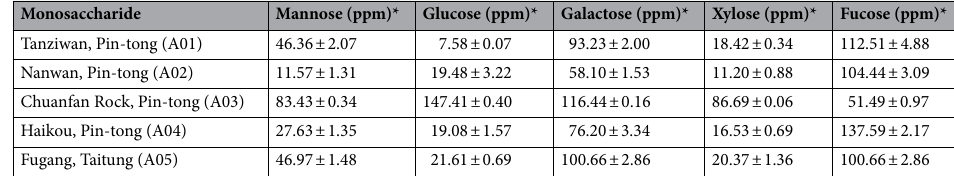
Table 2. Monosaccharide composition identification results of fucoidan. *Each value represents the mean ± SD of three determinants of the obtained fractions.